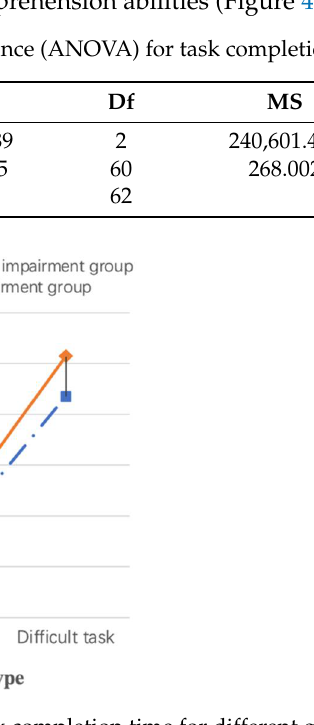
Figure 4. Mean value graph of task completion time for different groups.